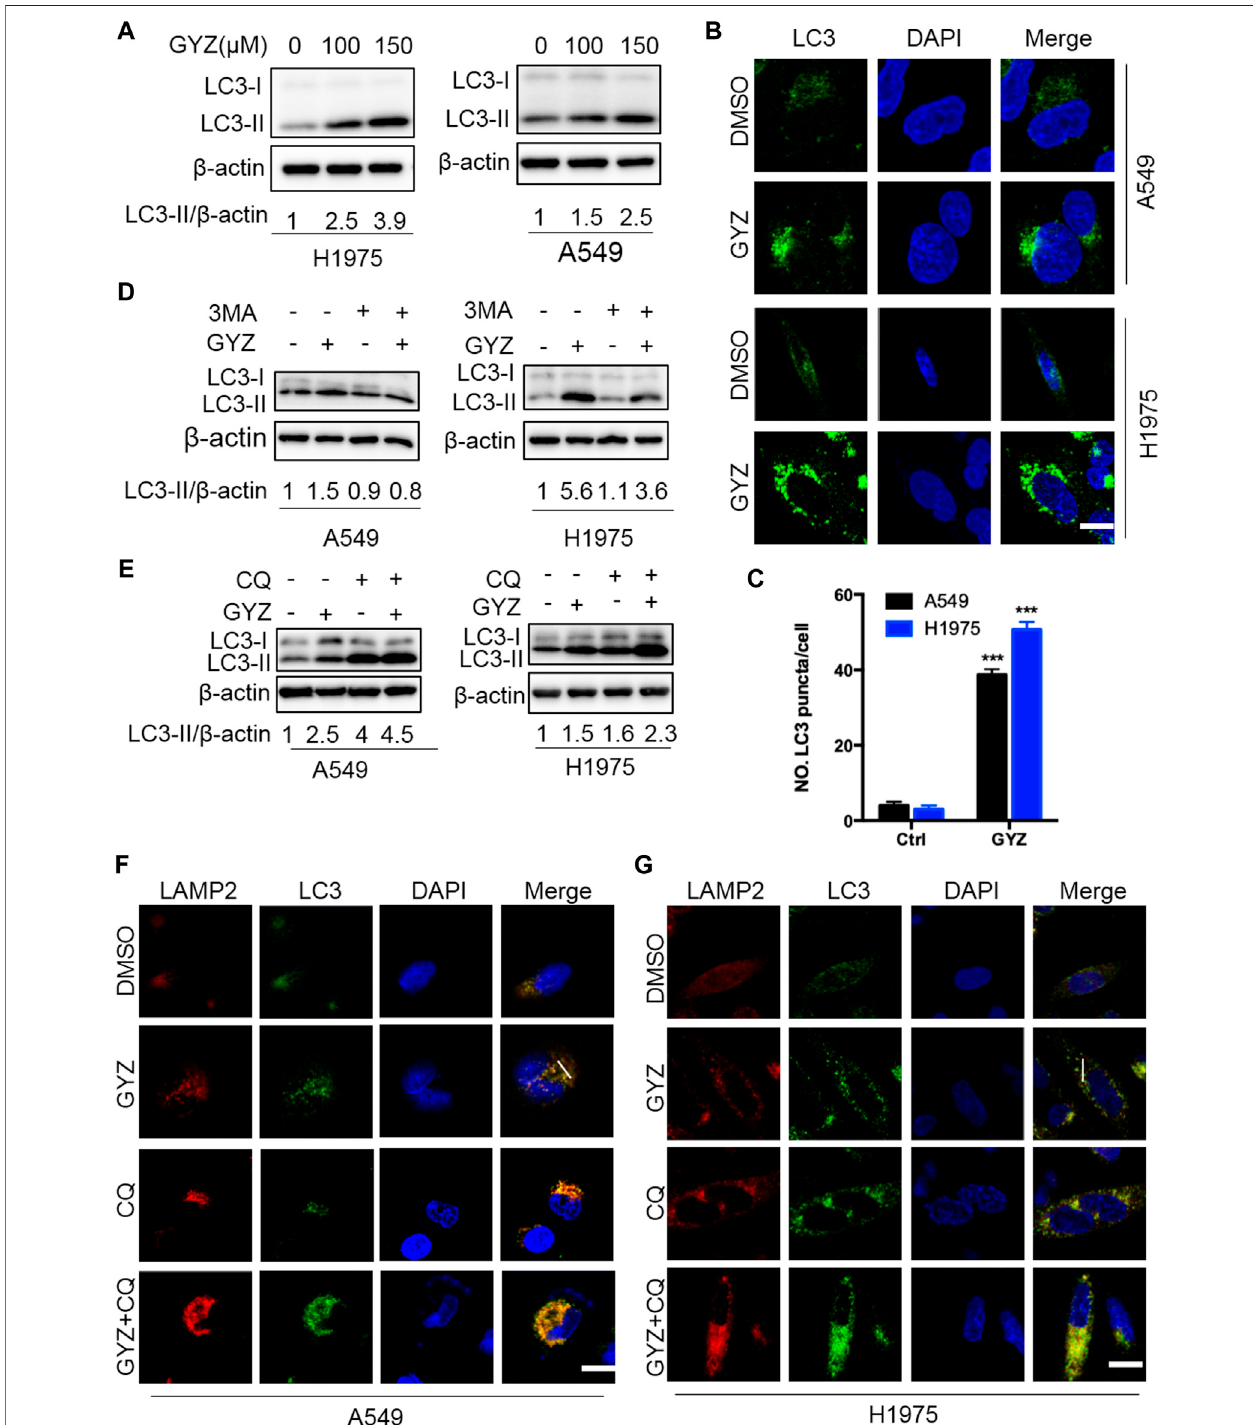
FIGURE 4 | GYZ stimulates autophagy in NSCLC cells. (A) Immunoblot analysis of LC3 turnover expression in NSCLC cells treated with vehicle or GYZ for 24 h. (B,C) Immuno fl uorescent analysis of the accumulation of endogenous LC3 puncta in the absence or presence of GYZ (A549 150 μ M, H1975 100 μ M) for 24 h. Scale bars,10 μ m. (D) NSCLC cellsweretreatedwithvehicle,GYZ(A549150 μ M, H1975100 μ M),3-MA(10 mM),orincombinationfor24 h. Immunoblot analysiswasused toexamineLC3turnover. (E) NSCLCcellsweretreatedwithGYZ(A549150 μ M,H1975100 μ M)withorwithoutCQ(5 μ M)for24 h.LC3turnoverwasdetectedby immunoblotting. (F,G) The colocalization of endogenous LC3 with LAMP2 was quantitated by immuno fl uorescent analysis in the treatment of GYZ (A549 150 μ M, H1975 100 μ M) with or without CQ (5 μ M) for 24 h. Scale bars, 10 μ m.